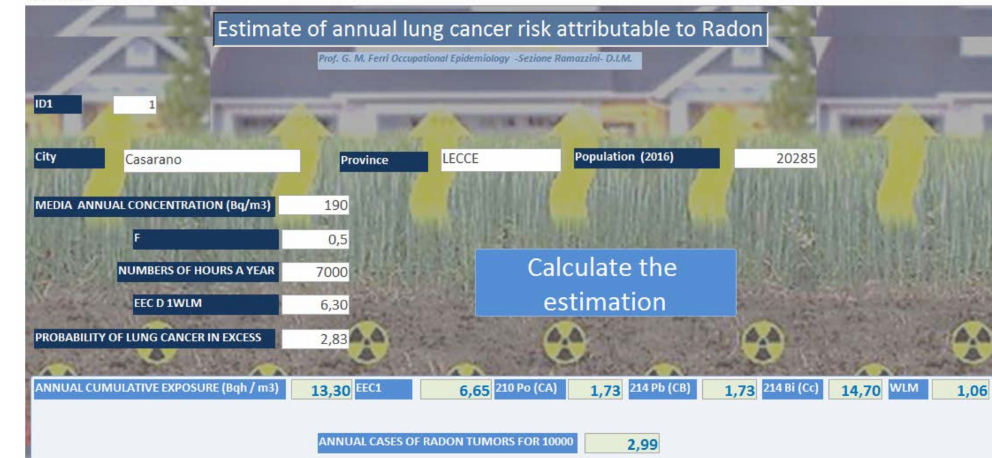
Figure 2. Mask of the software realized to produce the estimates of annual lung cancer attributable to radon. F (equilibrium factor) is the ratio between the concentration of the descendants and that of the radon; F (equilibrium factor) = EEC/C (EEC is the radon concentration equivalent to equilibrium); C is the radon concentration; EEC = 0.10CA + 0.52CB + 0.38Cc (CA, CB, Cc represent respectively the concentration of activity of the 210 Po, 214 Pb, 214 Bi radon decay products); WLM (working level month) is the cumulative exposure of 1 WL (working level) per working month of 170 h is the conventional exposure